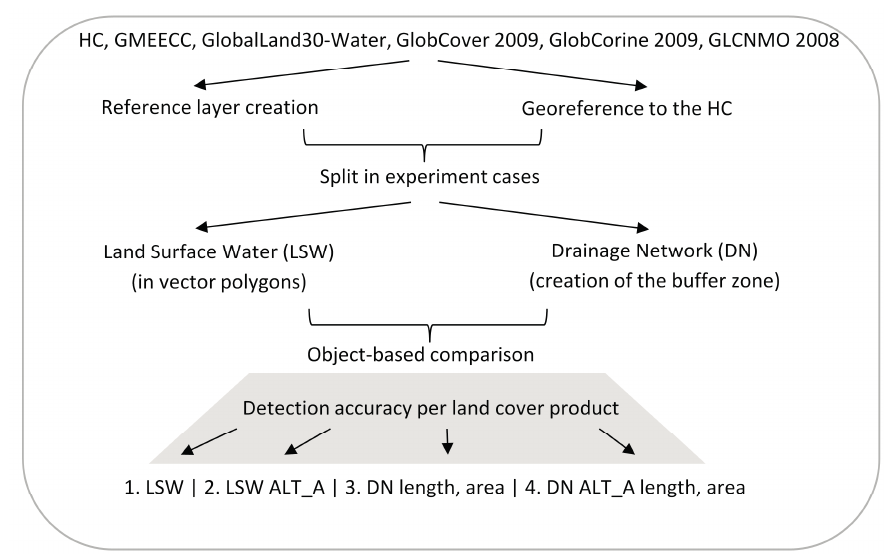
Figure 3. Methodology workflow (ALT_A: Alternative Approach; for HC, GMEECC, GlobalLand30-Water, GlobCover 2009, GlobCorine 2009, GLCNMO 2008 see Table